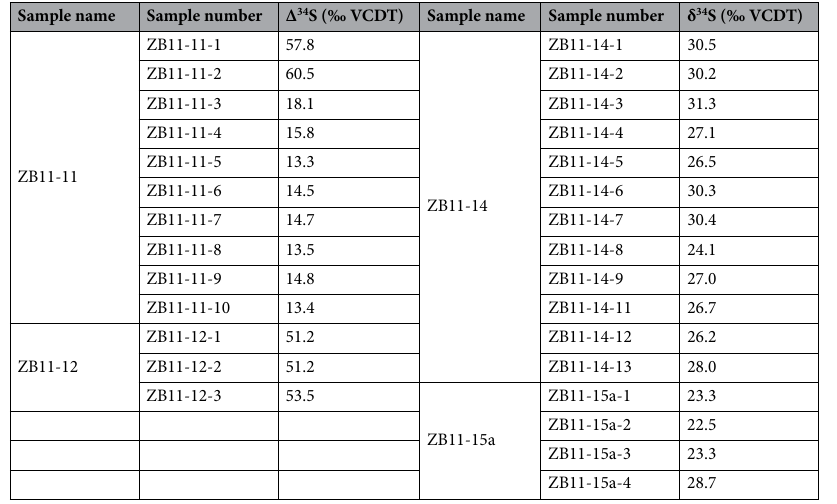
Table 3. Sulfur isotope composition of pyrite nodules in Taoying, Guizhou Province, southern China; sampled in 2 mm spatial